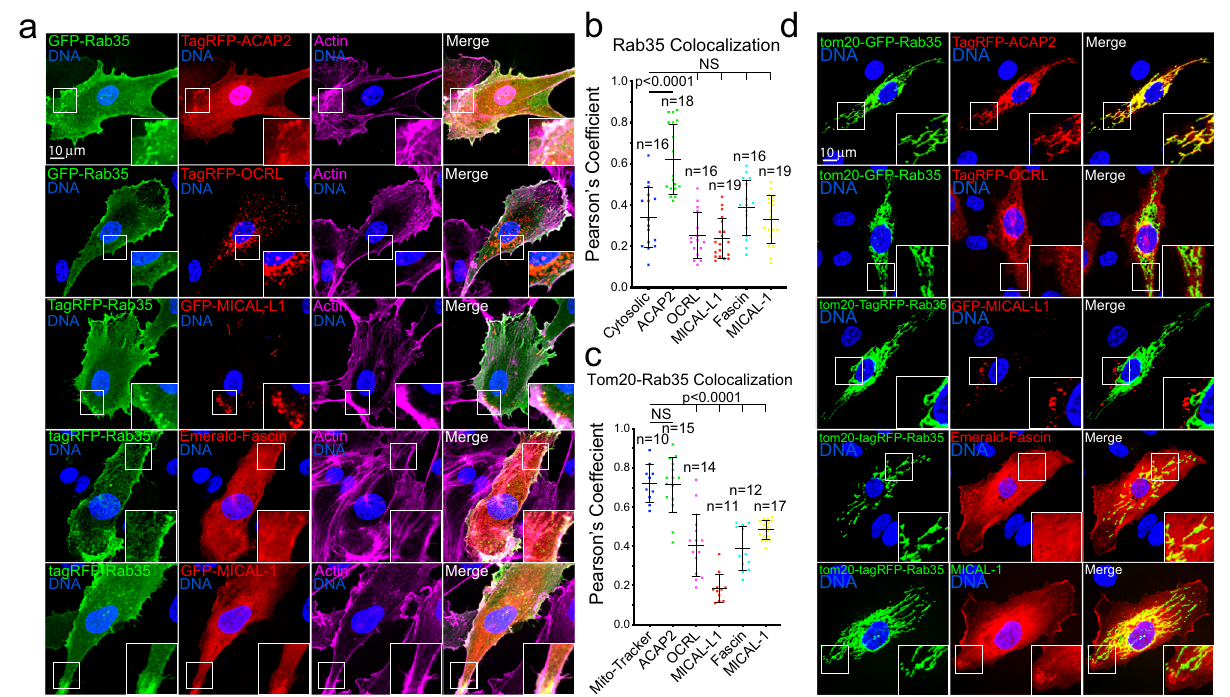
Fig. 4 | ACAP2binds with Rab35.a Two-dimensionallocalization ofGFP-Rab35 or TagRFP-Rab35 with indicated effectors and stained for actin. b Pearson ’ s Coef fi - cient between Rab35 and indicated effectors. n =number of cells. Error bars represent standard deviation, middle bars are the mean. c Pearson ’ s Coef fi cient between Tom20-Rab35 and indicated effectors. n= number of cells. Error bars represent standard deviation, middle bars are the mean. d Representative images